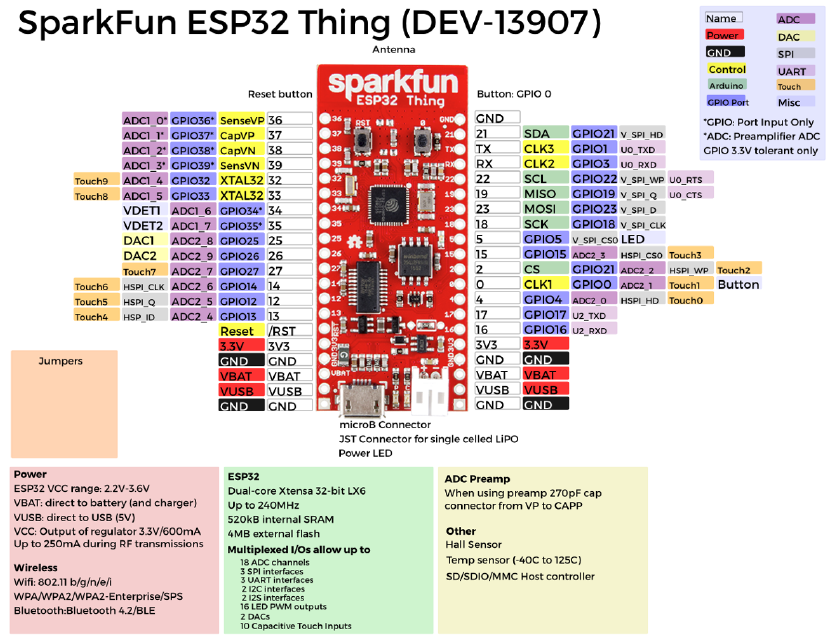
Figure 5. Hardware and peripherals specification summary of the ESP32